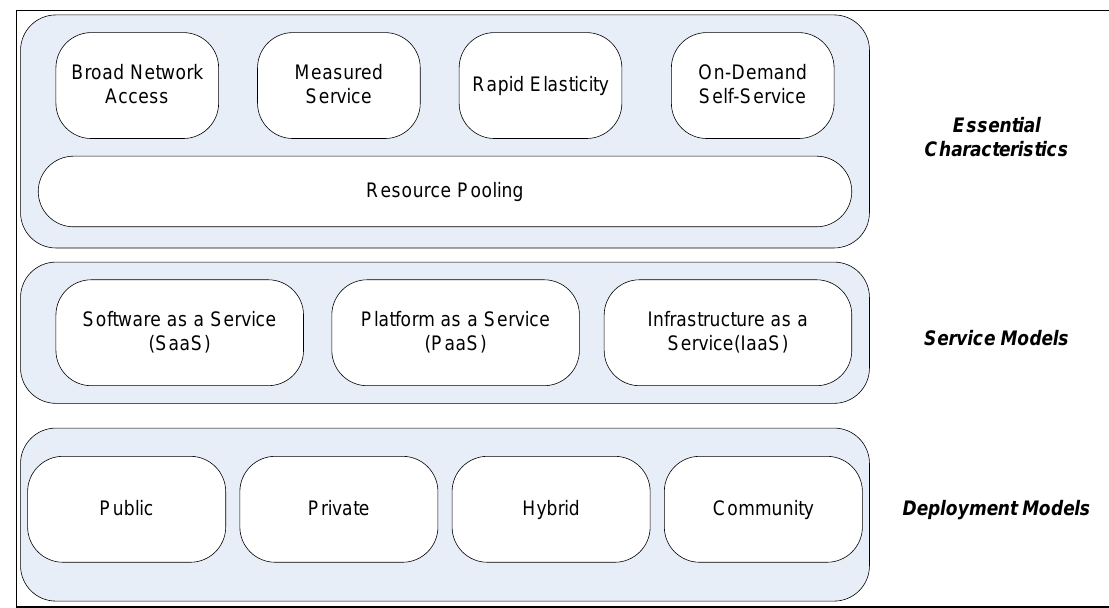
Figure 1: Cloud computing defined. Adapted from (CSA, 2009) (CSA,